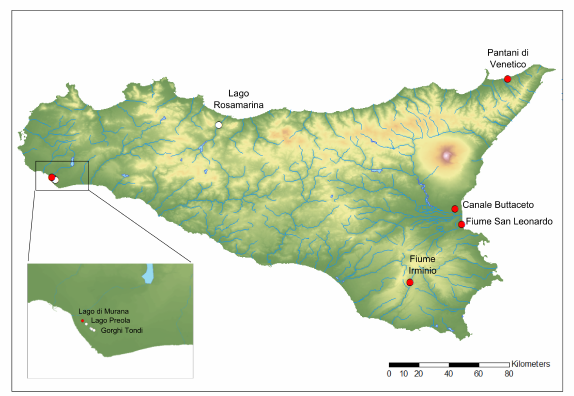
Figure 1. Map of the published (white circles) and novel (red circles) occurrence sites of Procambarus clarkii in